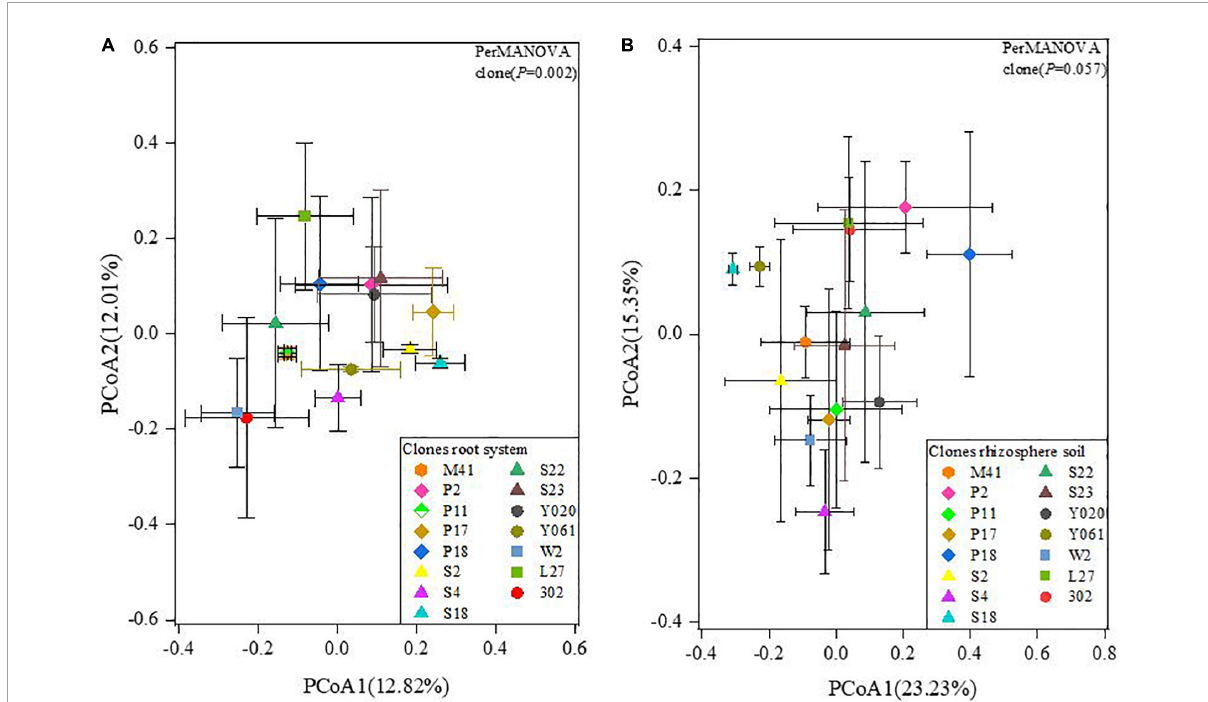
FIGURE8 PCoA analysis of AMF community in root (A) and rhizosphere soil (B) of different Chinese fir clones. The numbers in the lower right corner represent the different clones.